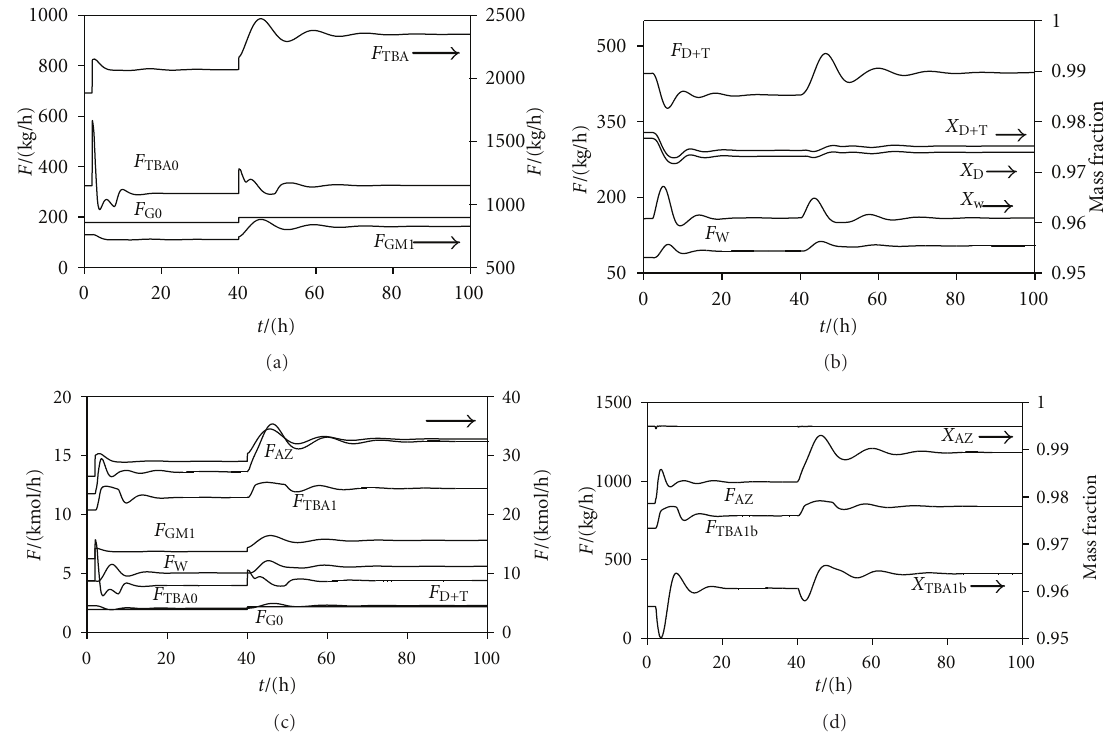
Figure 9: Dynamic simulation results. Refer to Figures 7 and 8 for nomenclature of various streams. x TBA1b and x AZ are mass fractions of TBA in streams TBA1b and AZ. x D is the mass fraction of diether in the product stream D +